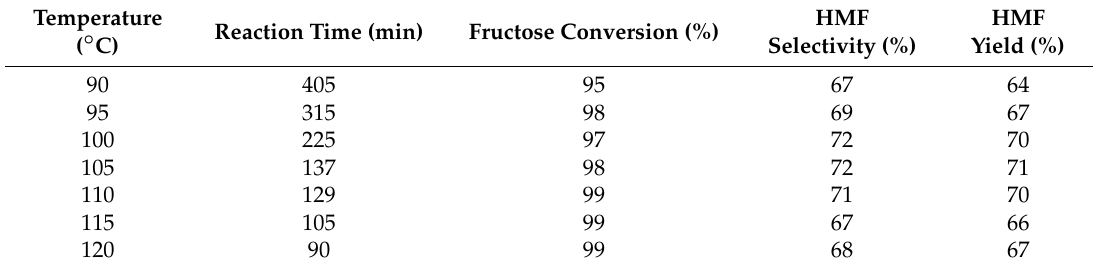
Table 1. Effect of temperature on fructose conversion, HMF selectivity and HMF yield.